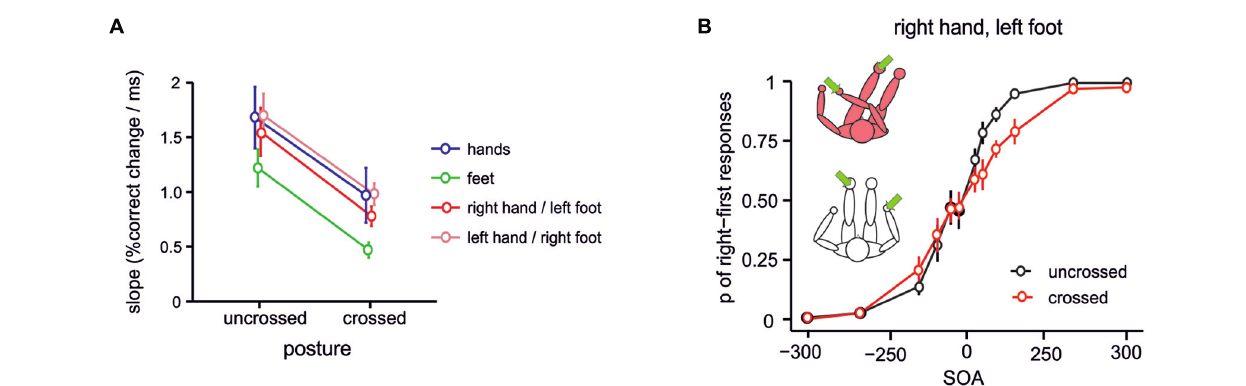
crossed conditions with different combinations of hand and foot stimuli. A crossing effect was present for all combination of stimulated limbs. (B) TOJ performance for stimulation of the right hand and left foot. Figure modified from Schicke and Röder (2006), Copyright (2006) National Academy of Sciences,